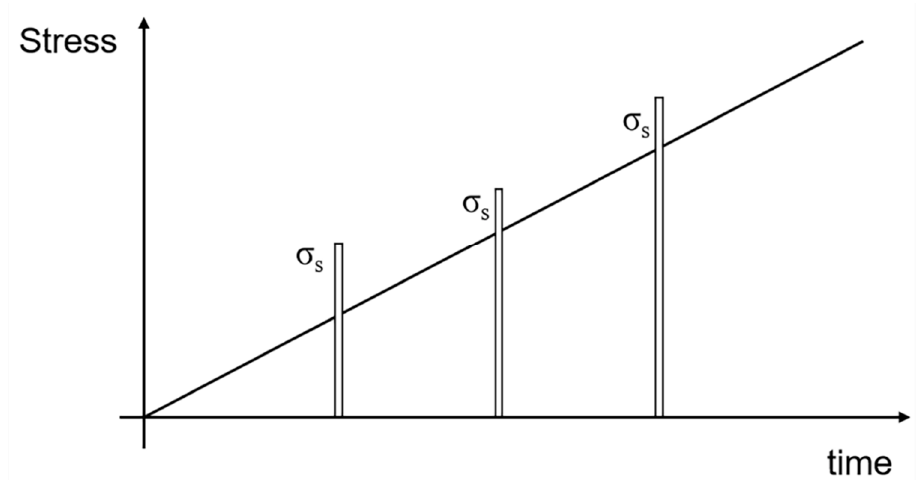
Figure 1. The diagram of stochastic loading under tensile loading.